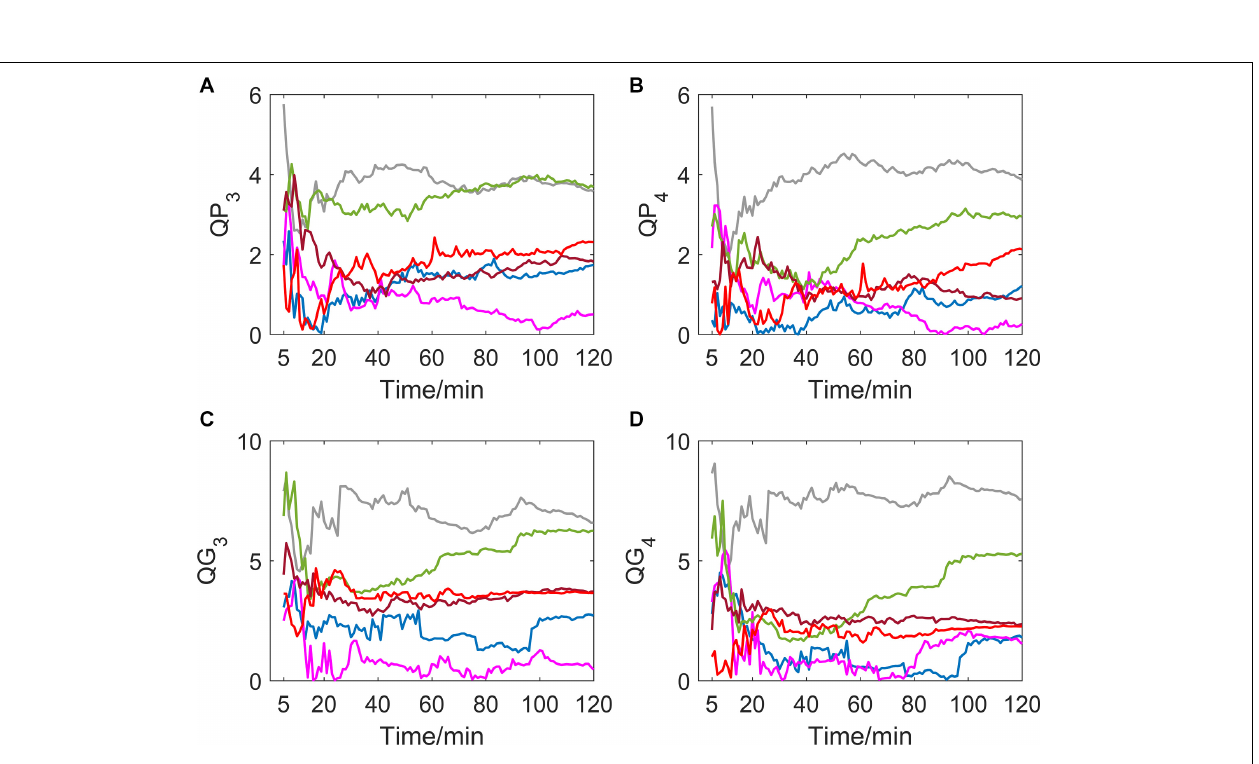
Frontiers in Physiology |